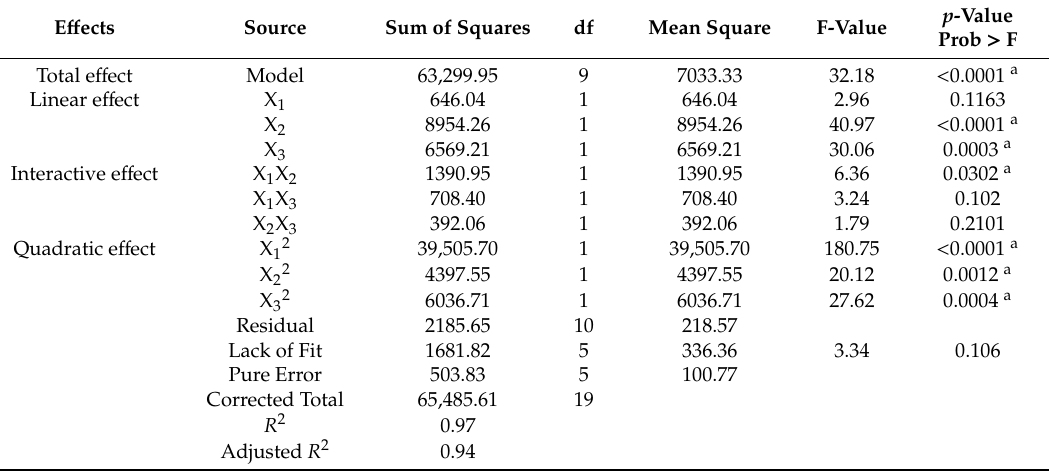
Table 2. The ANOVA analysis for the response surface quadratic model. df—degrees of freedom. E ff